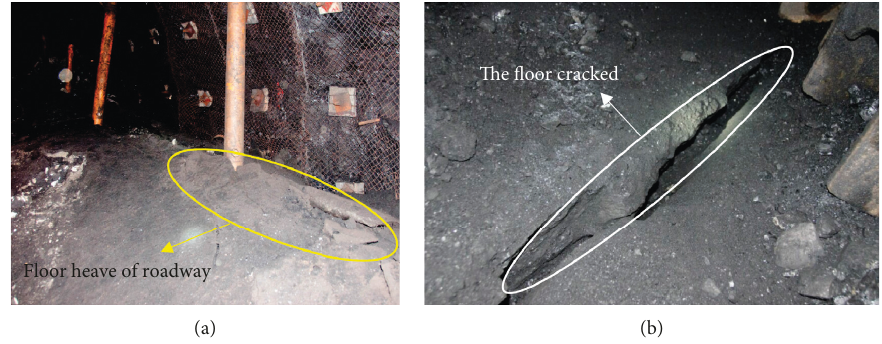
Figure 13: Coal burst in the roof roadway. (a) Floor heave of the roadway. (b) Cracking of the roadway